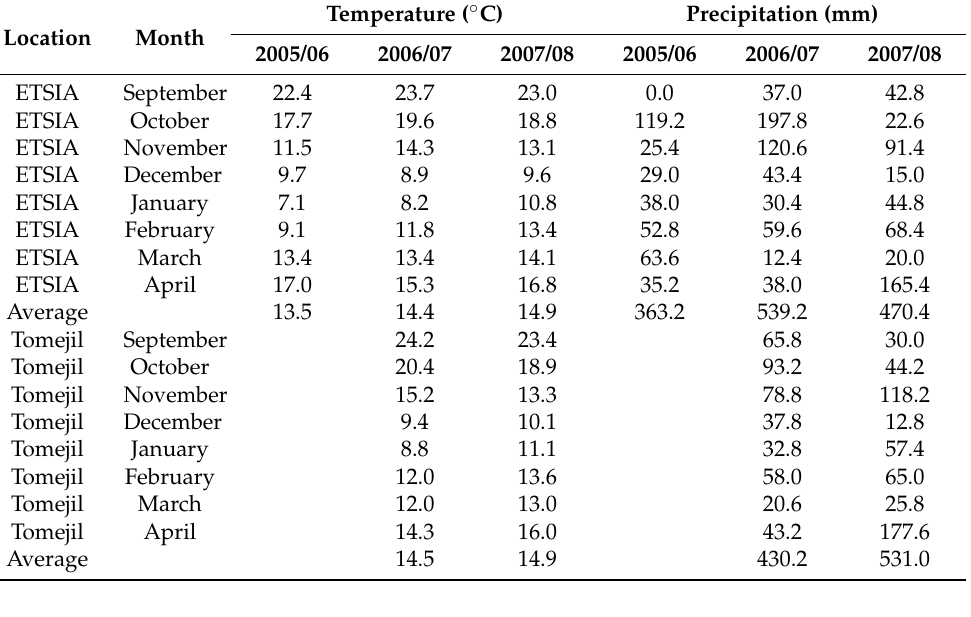
Table 4. Average monthly temperature and total monthly precipitation at each experimental location during the experiment.